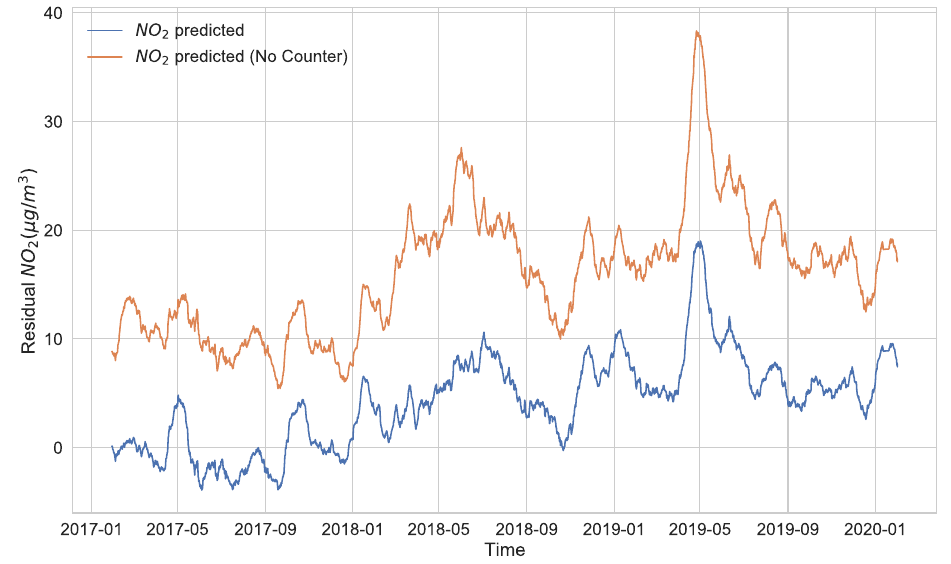
Figure 7. Moving averages (four-weekly) of the difference between the prediction and observation, each for a model with and without the counter as an input feature.